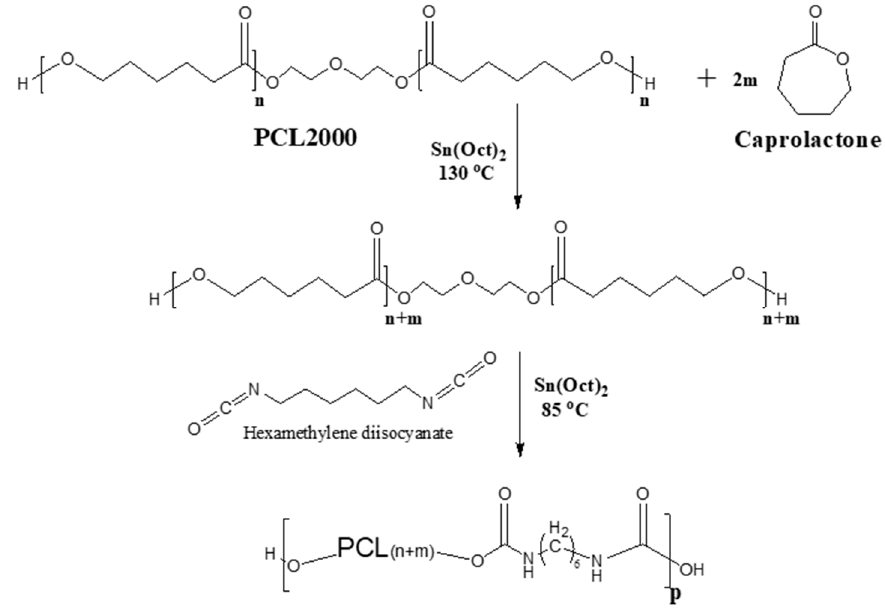
Figure 2. The reaction scheme of CLUR synthesis.